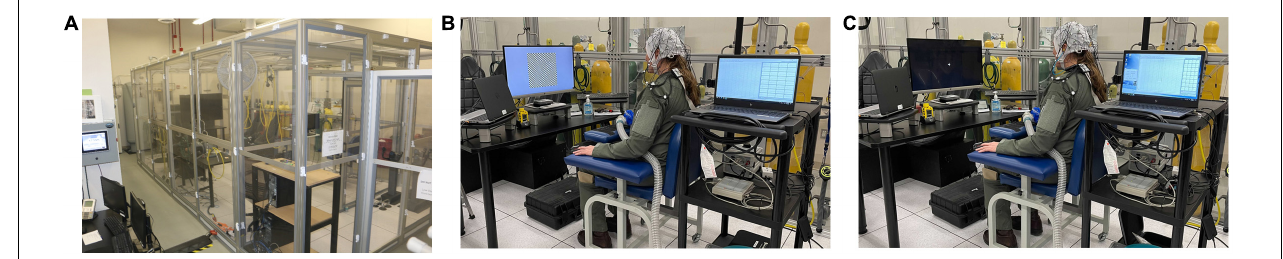
FIGURE 1 | (A) Reduced Oxygen Breathing Environment (ROBE) where all study visits took place. (B) Visual experimental setup. (C) Auditory experimental setup. Photos courtesy of NAMRU-D.